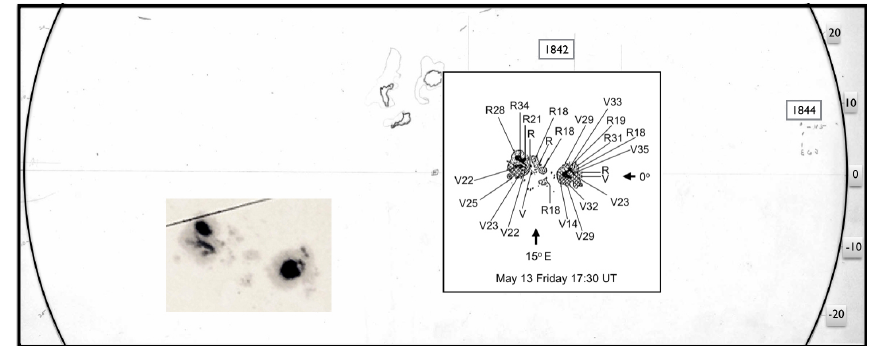
Figure 1. Mount Wilson drawing of active regions occurring on 13 May 1921 at 17:30UT and to the left, a white-light observation by Royal Greenwich Observatory (RGO) at